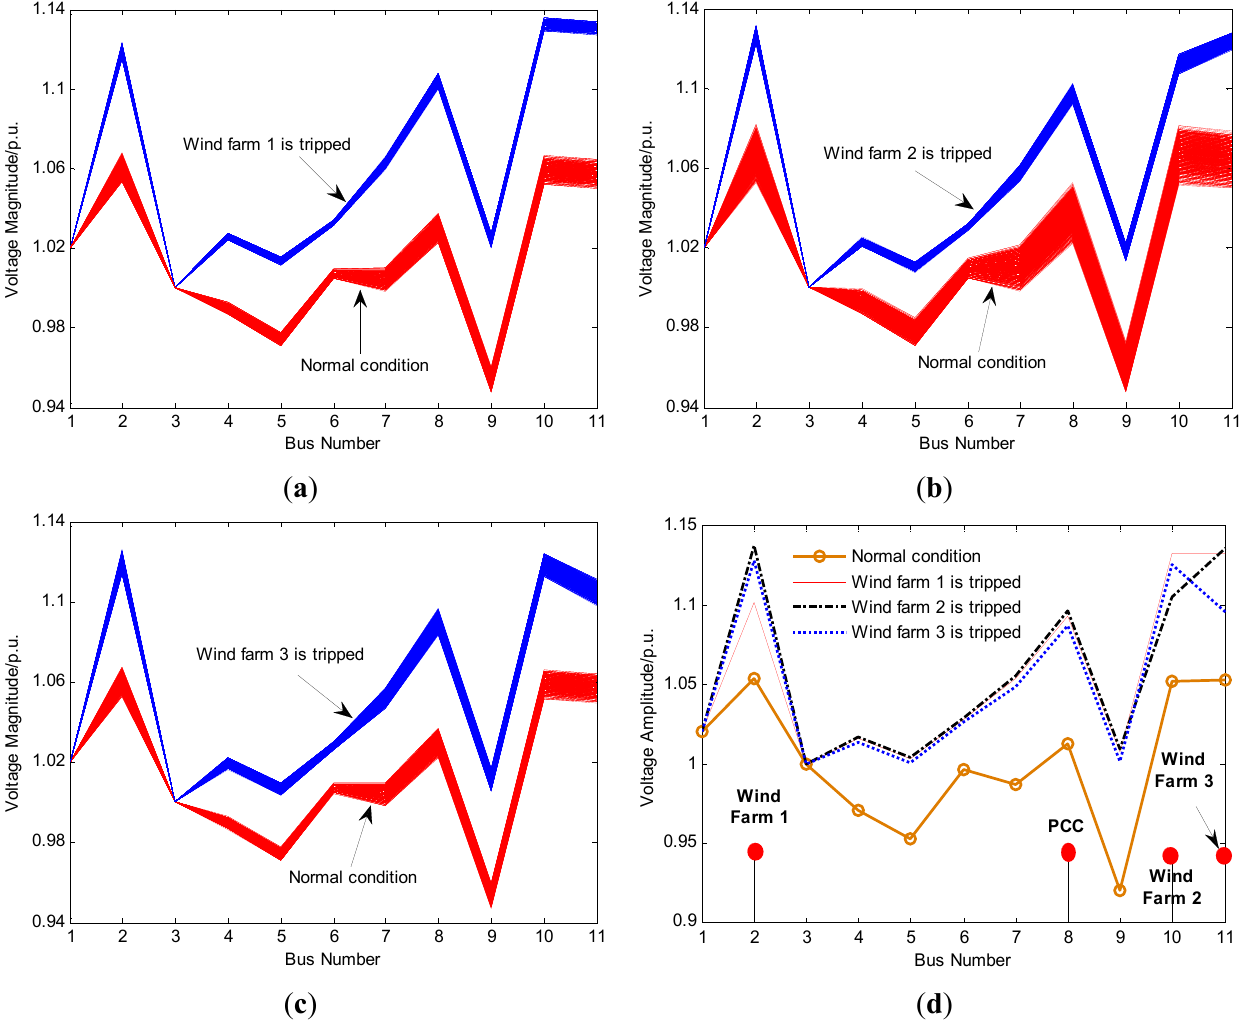
Figure 6. Bus voltage magnitude under normal condition and N-1 contingencies ( a ) wind farm 1 is tripped and the other wind power generation is stochastic; ( b ) wind farm 2 is tripped and the other wind power generation is stochastic; ( c ) wind farm 3 is tripped